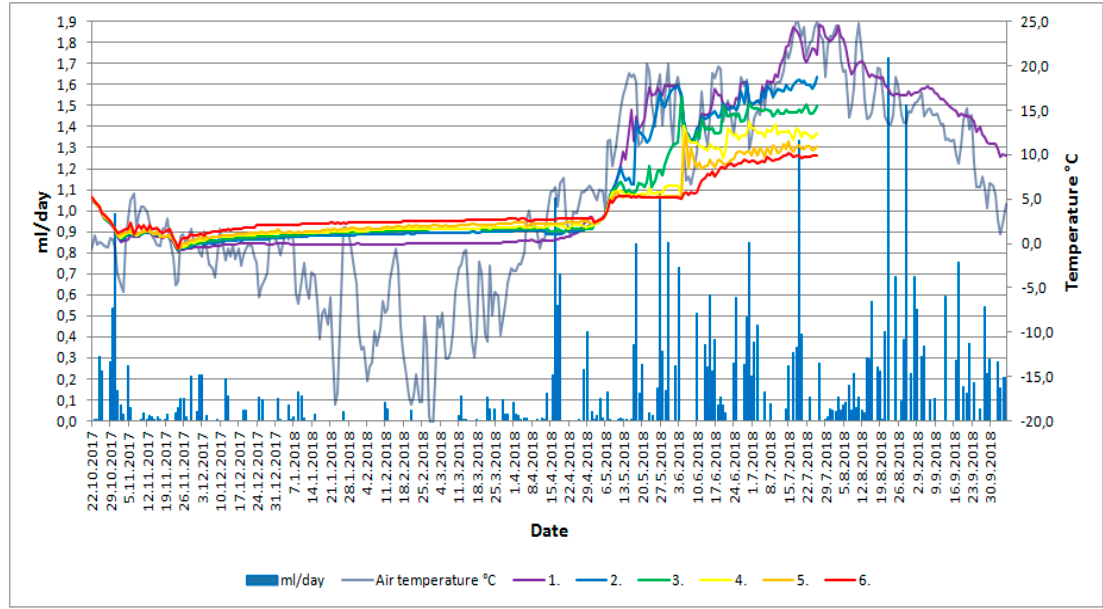
Figure 5. Daily sedimentation flux rate with respect to air temperature and basin water temperature at depths of 1 to 6 m, with one-meter interval, in Savilahti Bay from 22 October 2017 to 6 October 2018. Bar diagram shows sedimentation flux rate in mL/day and line diagram shows temperatures during investigation period: air (blue transparent line), water from 1 m depth (violet line), 2 m depth (blue line), 3 m depth (green line), 4 m depth (yellow line), 5 m depth (orange line), and 6 m depth (red line). Sedimentation flux rate increased when air temperature was above 0 °C and decreased when air temperature was below 0 °C. Note that water temperature from depths of 2 to 6 m are missing due hardware failure starting on 27 July 2018.